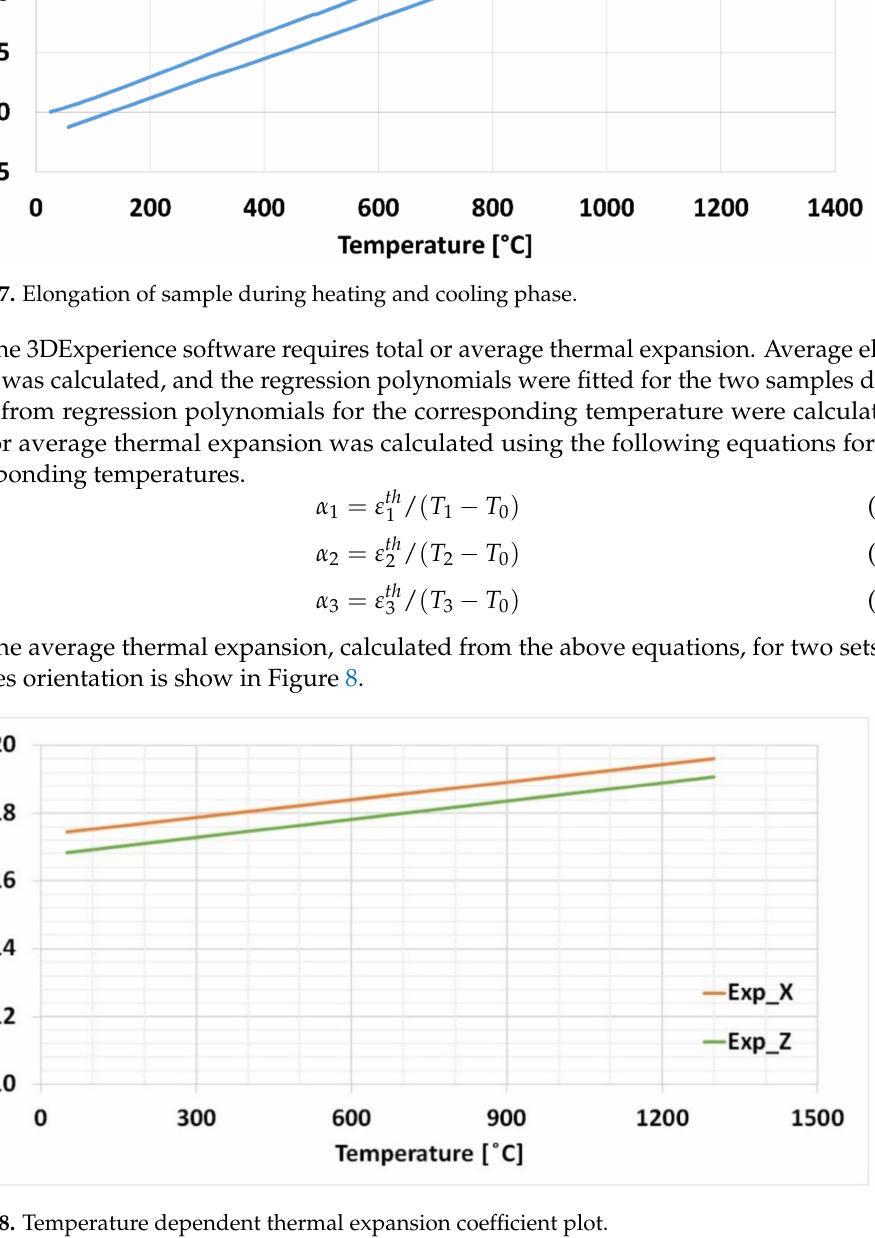
Figure 8. Temperature dependent thermal expansion coefficient plot. The CTE for two sets of samples calculation, depicted in Figure 8, show a similar slope for samples orientated in the x - and z -axis. Therefore, one set of the plot values were considered for numerical